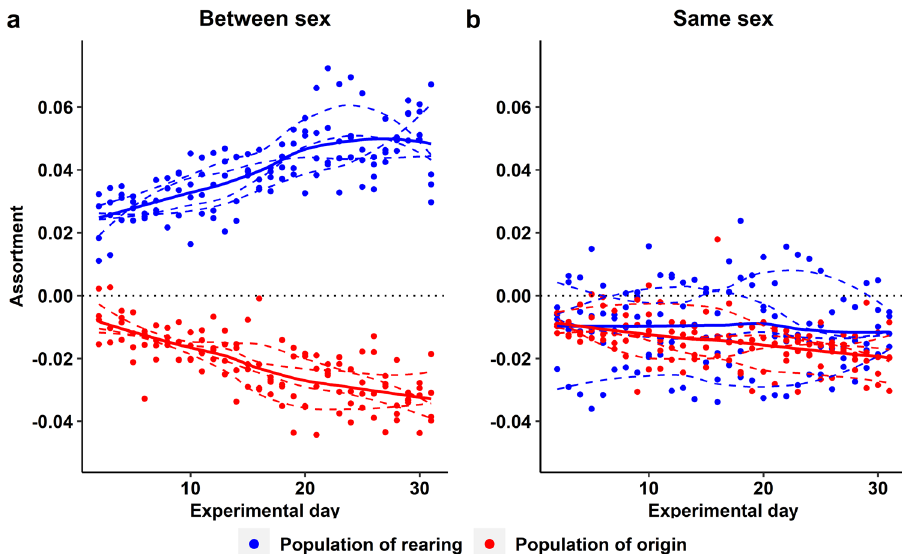
Fig. 6 Temporal changes in level of assortment between individuals from the same and opposite sex in Generation 2. Daily values of assortativity coef fi cients with regard to population of rearing (cultural background, blue) and population of origin (genetic background, red) in each of the four replicate groups. Coef fi cients are calculated using the distances between all male-female pairs (between sex, ( a )) or using the distances between all male-male and all female-female pairs (same-sex, ( b )). Positive and negative coef fi cient values indicate assortative and disassortative association, respectively. Dashed lines are fi tted to each of the four groups separately; the bold lines indicate the fi t to the entire data set. Note how in ( a ) heterosexual relationships (based on proximity) progressively become more assortative for the cultural background and more disassortative for the genetic background, while same-sex relationships show no clear deviation from